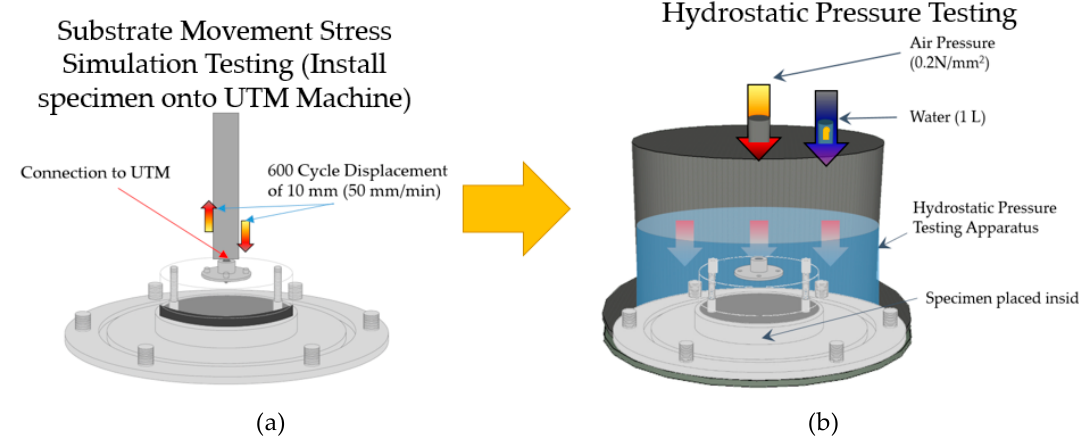
Figure 12. The substrate behavior resistance test method: ( a ) the substrate behavioral movement cycling procedure and ( b ) the permeability testing (hydrostatic pressure testing).